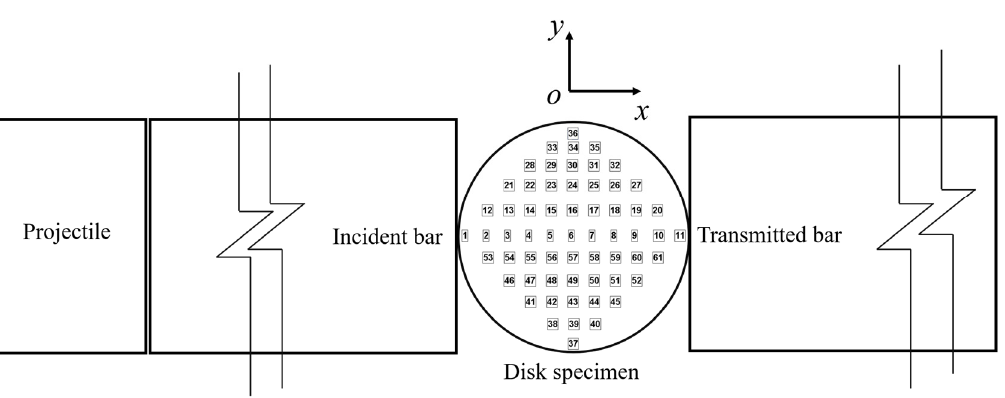
Table 1. Material parameters of JHC model .